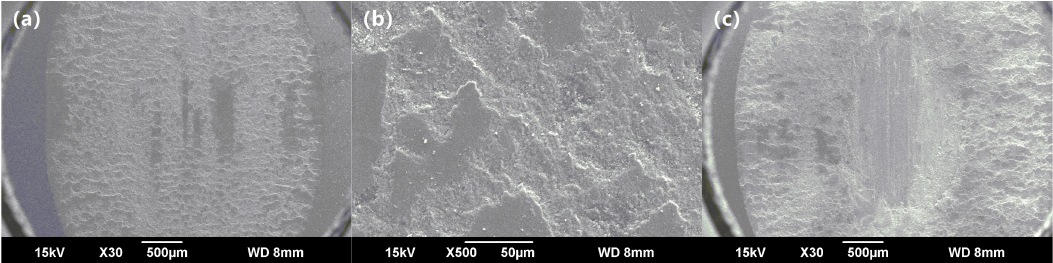
Figure 11. SEM image of the wear trace under the different load and sliding speed. ( a ) and ( b ) are the images tested at 100 N and 30 mm/s, respectively; and, ( c ) is the image tested at 200 N and 10